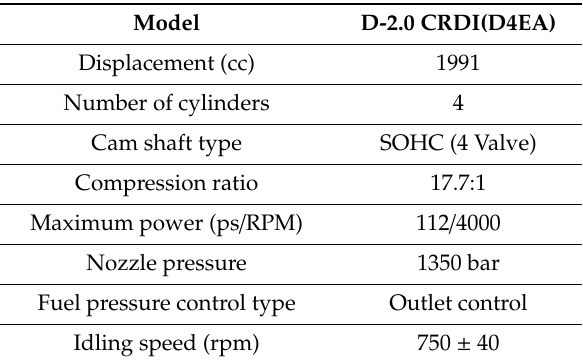
Table 1. Specifications of common rail diesel engine.